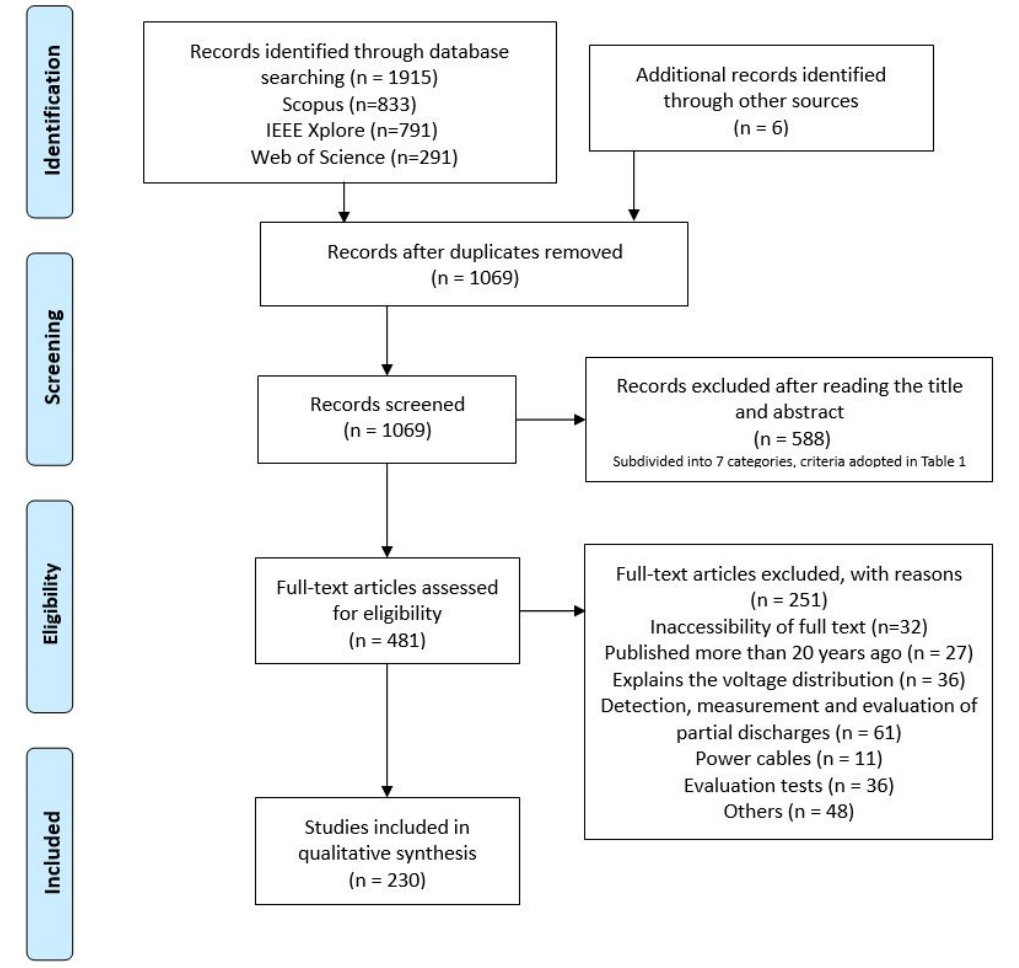
Figure 1. Selection of articles from bibliographic portfolio. Table 3. Number of articles published in respective journals and